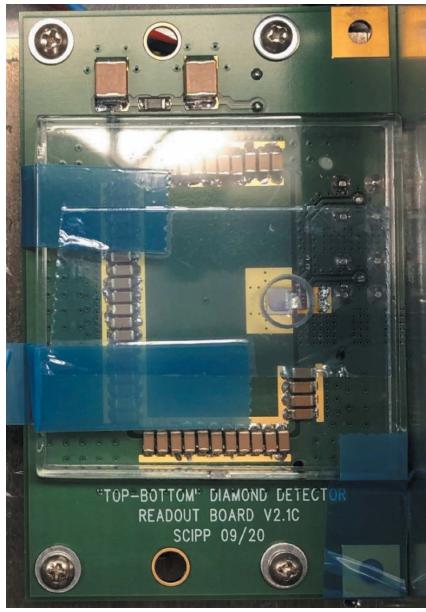
Figure 4 Full view of the SCIPP assembly showing the AC return path provided by a highly parallelized array of 22 m F capacitors. Note that in this photograph the assembly is rotated 180 (cid:6) relative to that of Fig. 3. The detail shown in Fig. 3 is located underneath the hole in the protective plexiglass